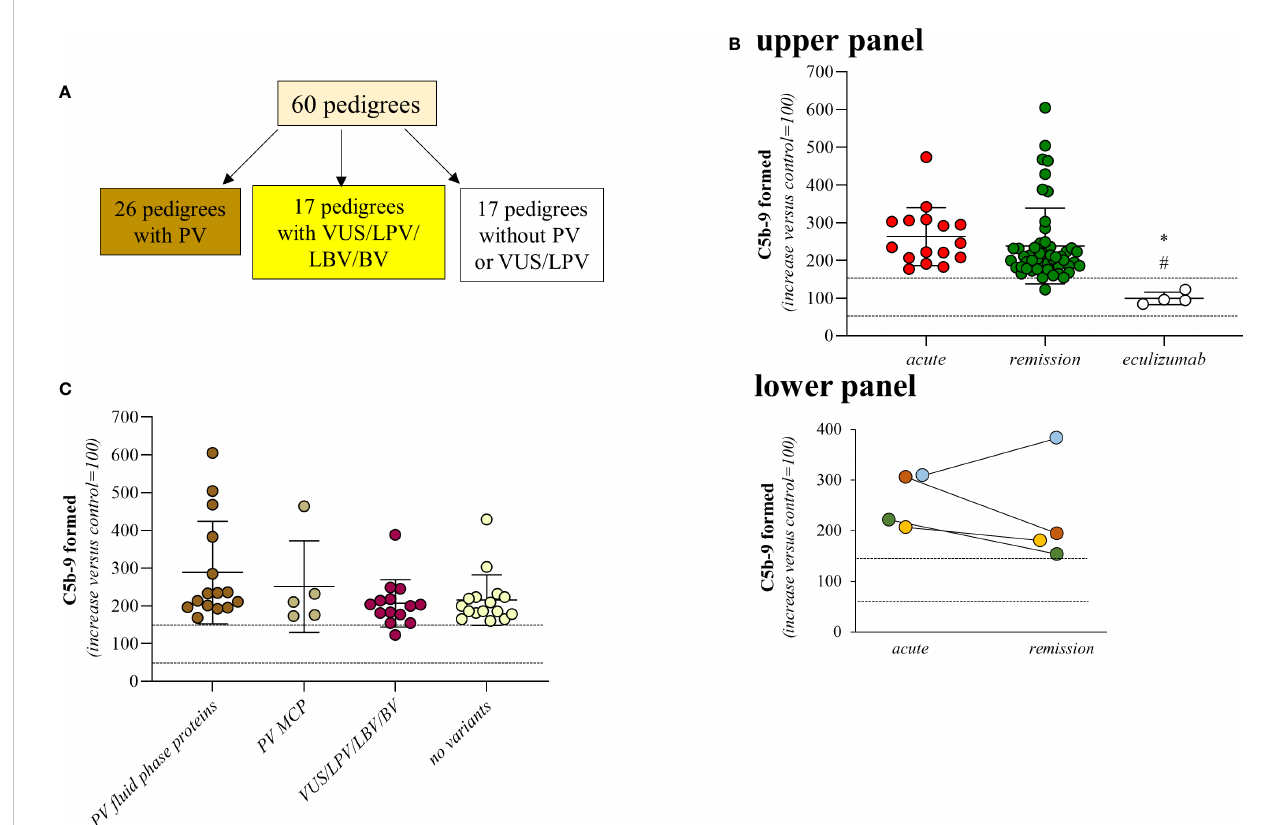
FIGURE 1 Serum from aHUS patients induces higher-than-normal C5b-9 formation on activated HMEC-1. (A) Distribution of rare complement gene variants among the 60 pedigrees. (B) Upper Panel, Endothelial surface area covered by C5b-9 staining after 2h incubation of ADP-activated HMEC-1 with serum (diluted 1:2 in test medium) from aHUS patients. Serum from aHUS patients was collected during the acute phase of the disease (n=16), or during remission (n=50), or during eculizumab treatment (n=4). Dotted lines are upper and lower limits of normal range. Lower Panel, Endothelial surface area covered by C5b-9 staining after 2h incubation of ADP-activated HMEC-1 with serum (diluted 1:2 in test medium) from aHUS patients. Serum from aHUS patients (n=4) was collected both during the acute phase of the disease and during the remission. Dotted lines are upper and lower limits of normal range. (C) Endothelial surface area covered by C5b-9 staining after 2h incubation of ADP-activated HMEC-1 with serum (diluted 1:2 in test medium) from aHUS patients who were in remission. aHUS patients were subdivided into carriers of pathogenetic variants (PV) in genes encoding fl uid phase complement proteins (n=15), or pathogenetic variants (PV) in the MCP gene only (n=5), or VUS/LPV/LBV/BV (n=14) or non-carrier of rare variants (n=16). Dotted lines are upper and lower limits of normal range. The results are shown as the fold increase of stained surface area after incubation with aHUS serum versus control pool of sera run in parallel. Points represent fold increase values of single subjects. Horizontal bars are mean ± SD values. *P<0.01 vs aHUS patients in acute phase, #P<0.05 vs aHUS in remission. PV, pathogenic variant; LPV, likely pathogenic variant; VUS, variant of uncertain signi fi cance; LBV/BV, likely benign/benign